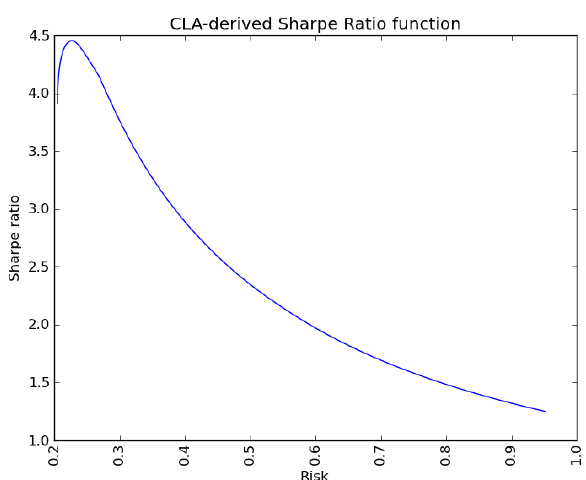
Figure 2. Sharpe ratio as a function of